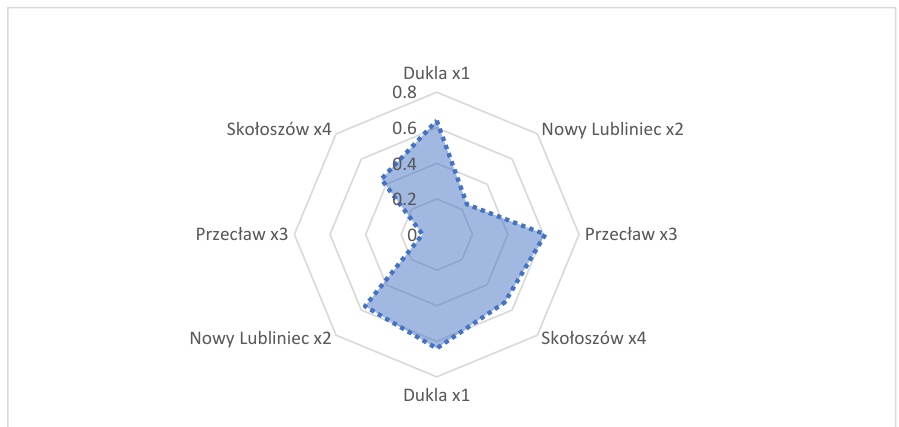
Figure 10. The relationship between fluctuations in rainfall level and various meteorological parameters. Y — yield; x1 — temperature of the April – may; x2 — temperature of June – July; x3 — temperature of August – September; x4 — rainfalls of April – September; x5 — indicators of hydrothermal of